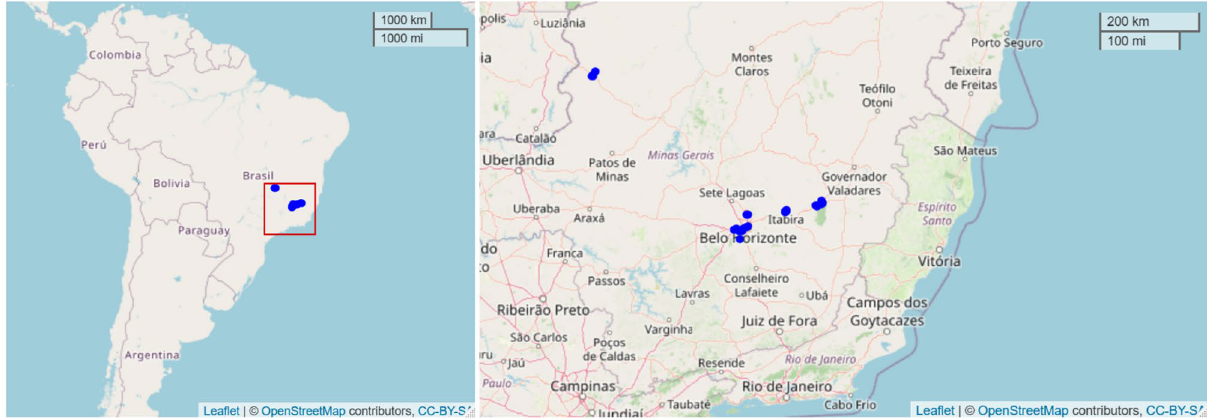
Figure 1. Map of South America (left) and map with the location of the monitoring stations (right). The source map was made with the R package leaflet, version